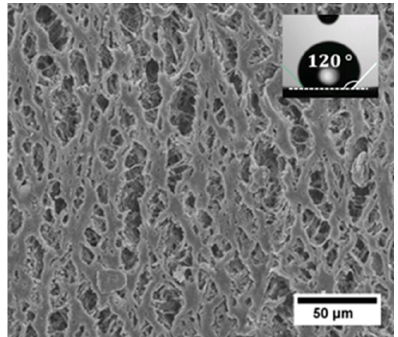
Figure 1. SEM photograph of the outer membrane surface. A snapshot for the macroscopic contact angle measurement is shown on top of the SEM image. The measurement is performed on a piece of unused membrane and the measured contact angle is about 120 °.